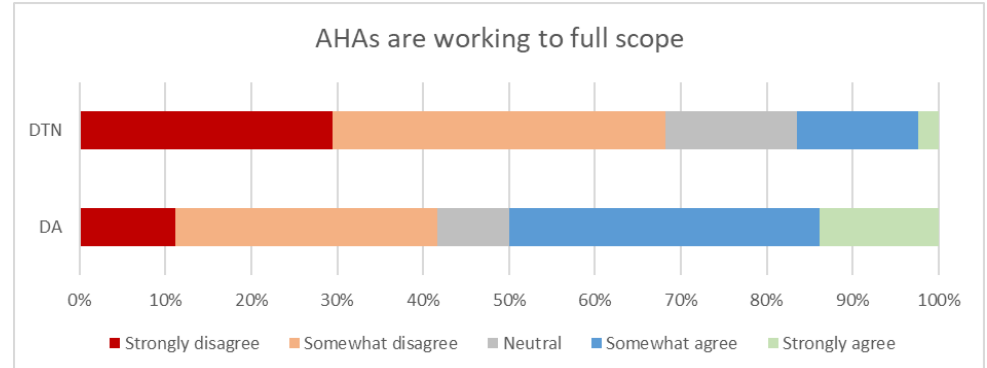
Figure 5. Dietitians’ (DTN) ( n = 85) * and dietitian assistants’ (DA) ( n = 36) * perception of dietitian assistants currently working to full scope. * Two dietitians and one dietitian assistant did not respond to this question.